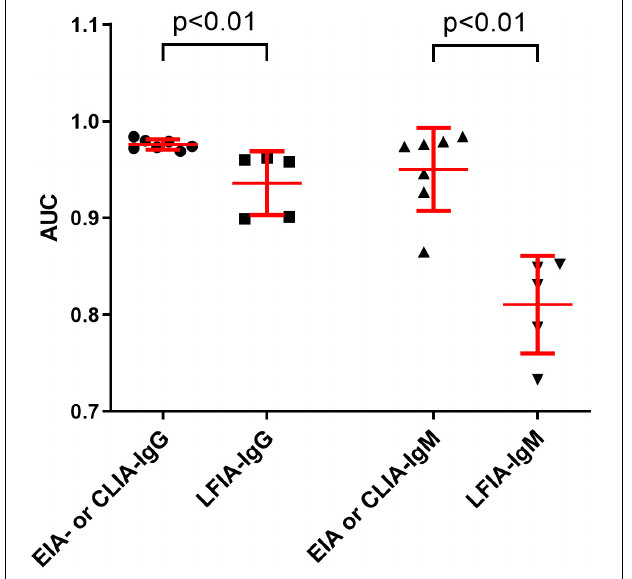
FIGURE 2 | Comparison of the AUCs between EIA- or CLIA-IgG and LFIA-IgG, and between EIA- or CLIA-IgM and LFIA-IgM. Data were expressed as mean and standard deviation. AUC, area under the curve.